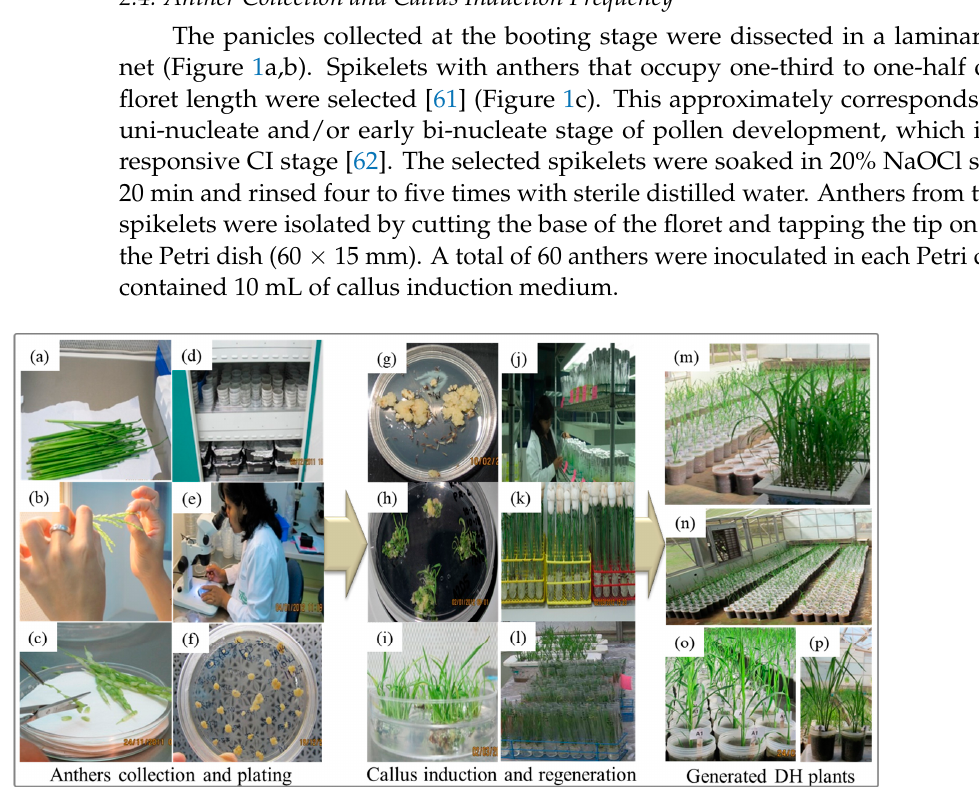
Figure 1. Depicted diagram of the generation of DH plants. ( a ) Boot collections; ( b ) Selection of spikelets at the proper stage; ( c ) Cutting the base of the floret and anther inoculation process; ( d ) Plated anther incubated at 25 ◦ C for 6–7 weeks for callus induction; ( e ) Examination of the anther plates at weekly interval for anther response and callus formation; ( f ) Calculation of callus induction frequency; ( g ) Callus proliferation; ( h , i ) Green plantlet regeneration in the regeneration medium; ( j ) Vigorous growing green plantlets in the test tube containing MS medium and incubated at 30 o C under 24 h light; ( k , l ) Regenerated green plantlets transferred to hydroponic nutrient solution and grown in the greenhouse at 29–30 °C temperature for two weeks; ( m – o ) Individual plants originating from single callus transplanted in pot condition; ( p ) Difference between haploid (right) and diploid (left) rice plants.